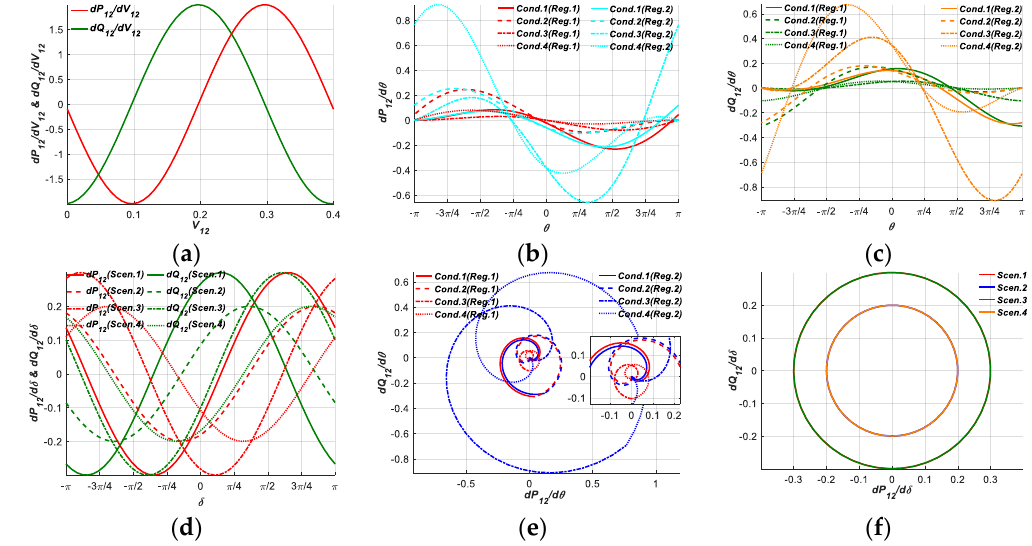
Figure 4. Curves of PFG to each CIV at SCP2 in planes: ( a ) Curves of the PFG to CIV1; ( b ) Curves of the APFG to CIV2. ( c ) Curves of the RPFG to CIV2; ( d ) Curves of APFG and RPFG to CIV3; ( e ) Curves of APFG against RPFG to CIV2; ( f ) Curves of APFG against RPFG to CIV3.